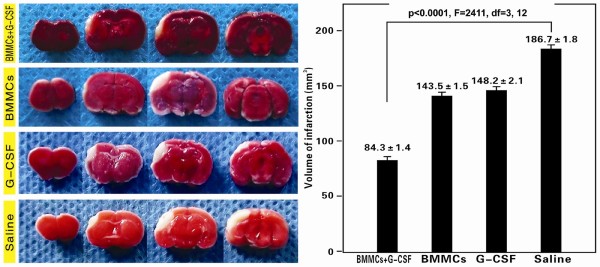
Representative images of TTC-stained brain slices and infarct volume analysis at 28 days post middle cerebral artery occlusion. Representative brain slice images (left) were taken at 24 hours following TTC staining. Bar graph on the right shows corrected infarct volumes (CIV) among 4 animal groups. For each brain the CIV value was calculated from slices at 2-mm intervals. Mean infarct volumes are reduced in BMMCs+G-CSF groups (84.3 ± 1.4) relative to BMMCs group (143.5 ± 1.5), G-CSF group (148.2 ± 2.1) and Saline group (186.7 ± 1.8); as well as between the BMMCs or G-CSF group relative to the saline group (Bonferroni's post-tests).